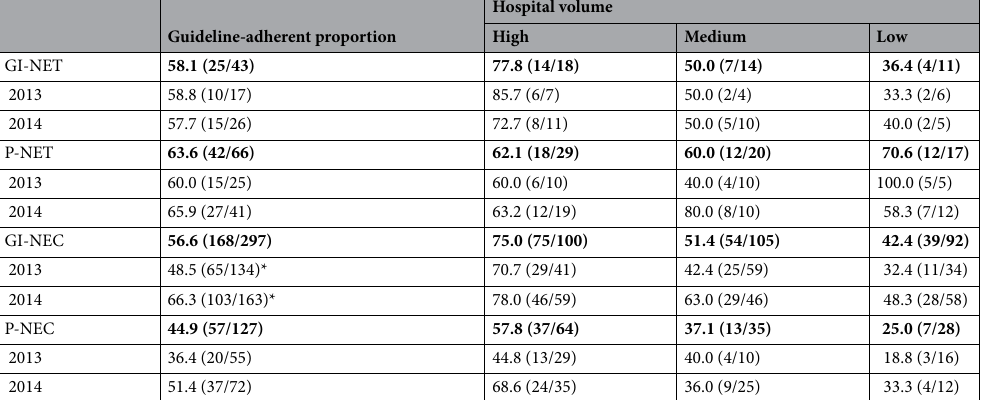
Table 5. Guideline-adherent proportion (%) calculated according to tumor classification, primary site, and hospital volume between 2013 and 2014. GI-NEC gastrointestinal neuroendocrine carcinoma, GI-NET gastrointestinal neuroendocrine tumor, P-NEC pancreatic neuroendocrine carcinoma, P-NET pancreatic neuroendocrine tumor. *Guideline-adherent proportion differed significantly according to year. Significant values are in